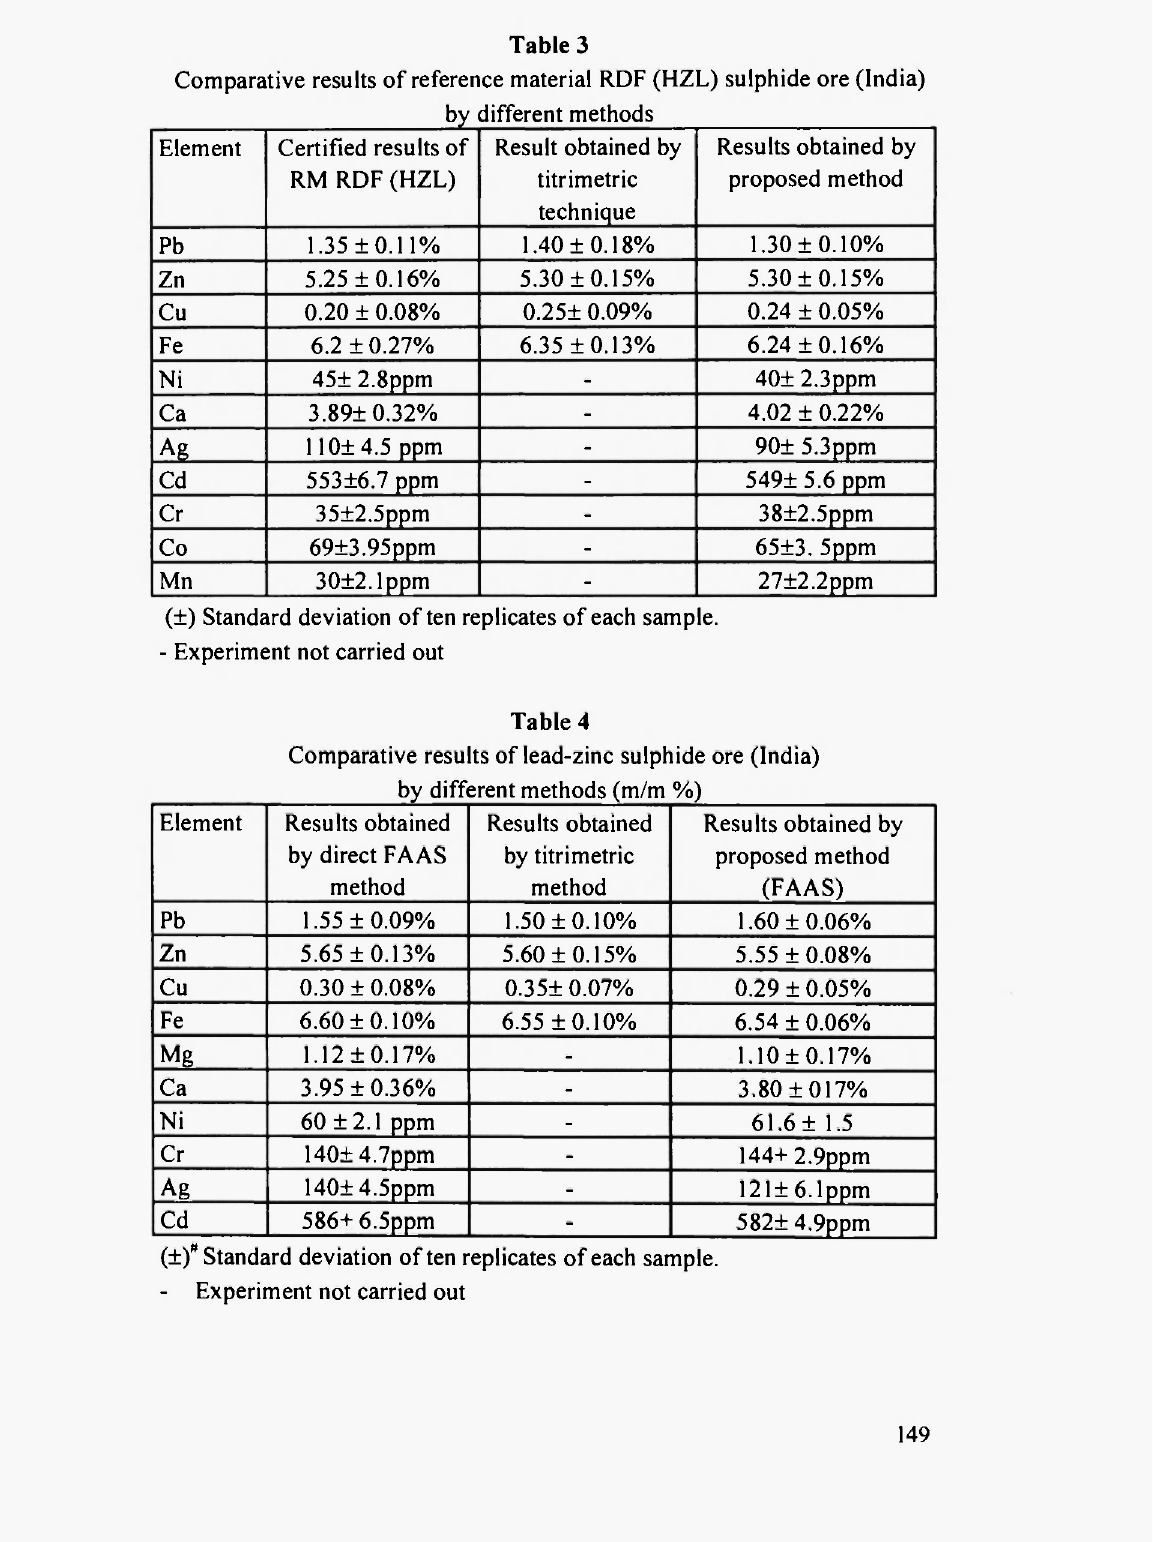
Comparative results of lead-zinc sulphide ore (India) by different methods (m/m